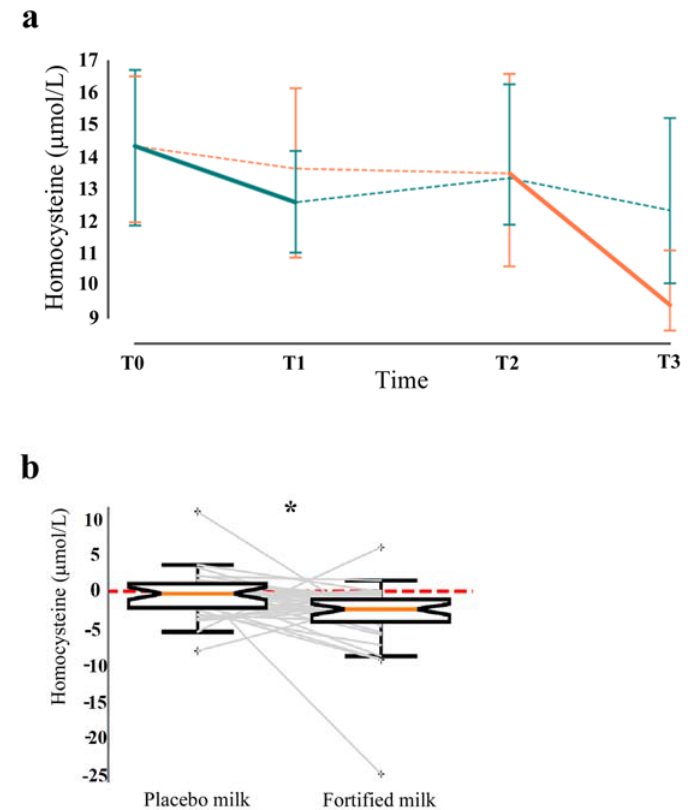
Figure 3. Circulating homocysteine levels. ( a ) Time-series visualization of circulating homocysteine levels in participants of both arms. ( b ) Boxplot of the variation of homocysteine in participants on placebo vs. those on fortified milk is displayed (q < 0.0001 *). Statistical analysis was performed by linear mixed effect model and a q-value (corrected p-value for the Benjamini–Hochberg multiple comparisons) < 0.05 was considered statistically significant. FP (green line) = arm: participants on fortified milk and then placebo, PF (orange line) = arm: participants on placebo and then fortified milk, Solid line = fortified milk, Dashed line = placebo milk/washout.